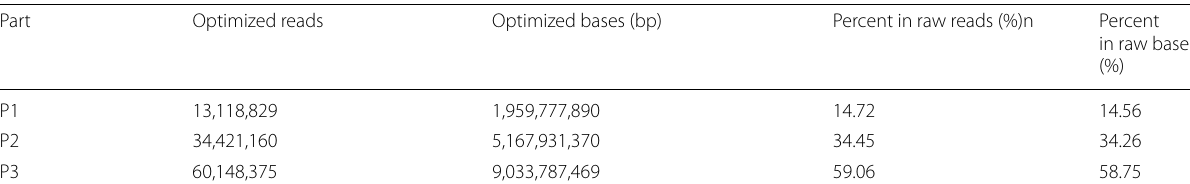
Table 1 Metagenomic sequencing data